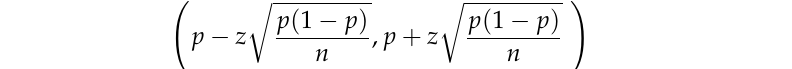
Figure 14. The sample proportion histogram of the cable labels identified by the test dataset with 2800 DIXVs. ( a ) Scenario ① ; ( b ) Scenario ② ; ( c ) Scenario ③ ; ( d ) Scenario ④ ; ( e ) Scenario ⑤ ; ( f ) Scenario ⑥ ; ( g ) Scenario ⑦ . The proportion confidence interval is calculated by Equation (21) to validate this method’s reliability.